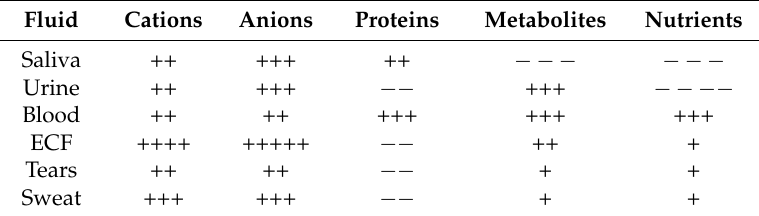
Table 3. Qualitative composition of selected biological fluids presented in this